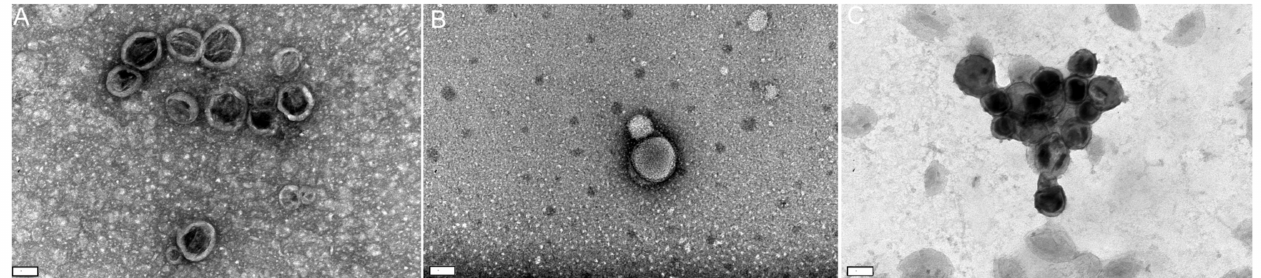
Figure 3. TEM images of the ( A ) EGCG-loaded, ( B ) resveratrol-loaded and ( C ) myricetin-loaded SLNs. The scale bar corresponds to 100 nm.